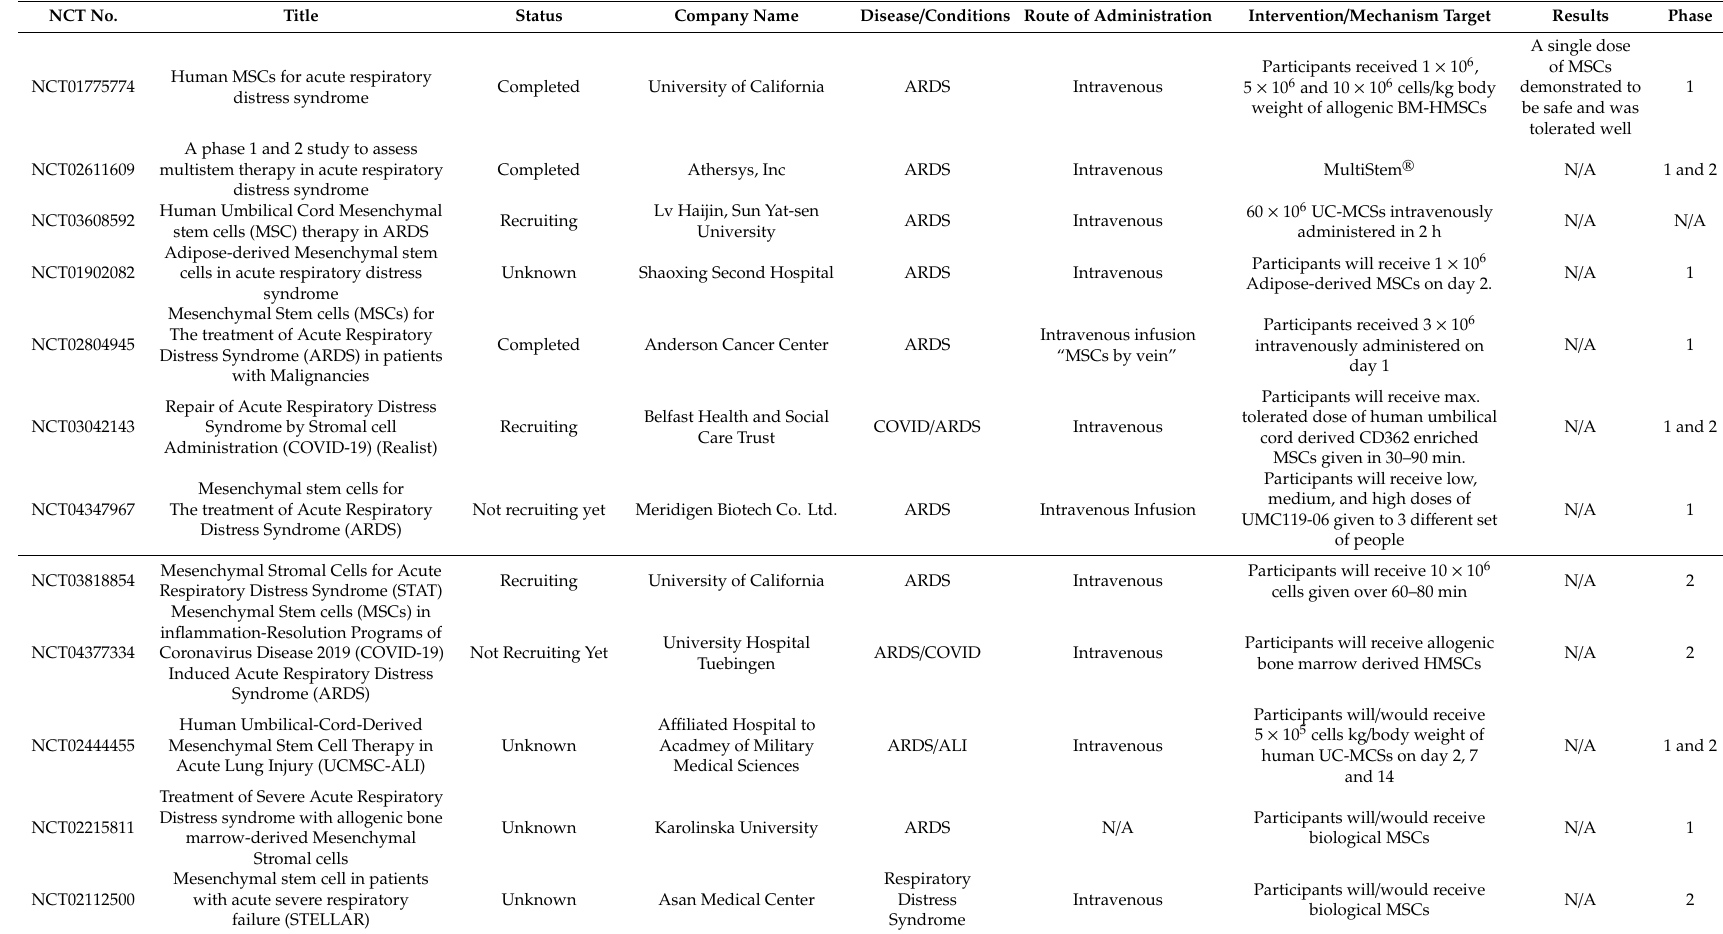
Table 1. Mesenchymal stem cell (MSC)-based therapy clinical trials for ARDS (acute respiratory distress syndrome). NCT